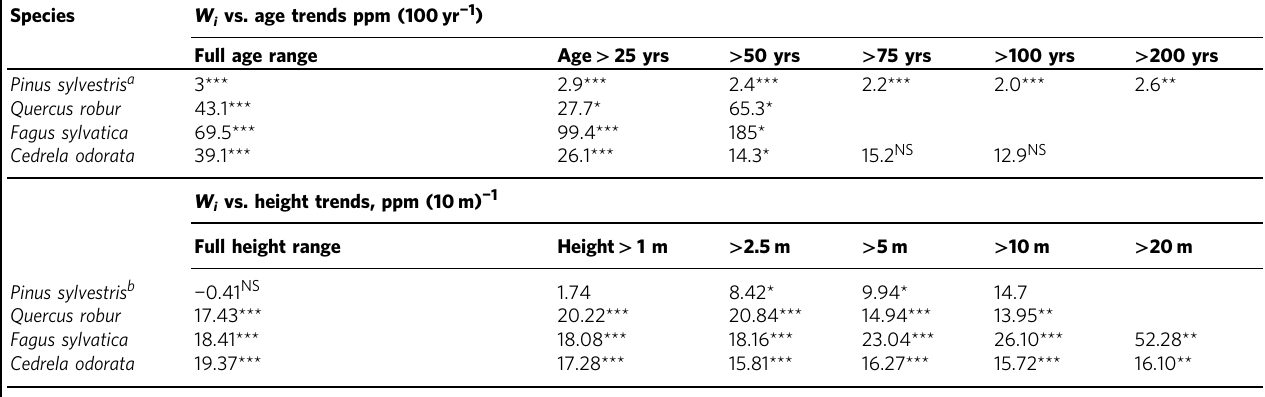
Table 1 Analysis of age- and height-related changes in W i for different life stages